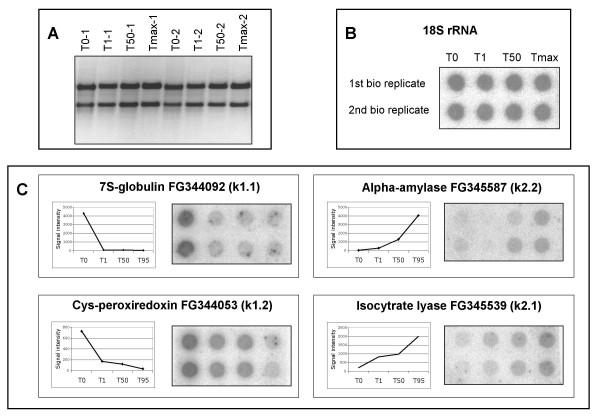
Comparison of results obtained by macroarray and RNA dot-blot analysis. (A) Gel-electrophoresis of RNA samples used for experiments, 1 μg of total RNA is loaded. (B) Control RNA dot-blot: 18S rRNA. (C) Graphical representations of gene expression data obtained by macroarray technique are shown adjacent to the corresponding RNA dot-blots. For (B) and (C): 5 μg of total RNA is loaded on a membrane and hybridized with a 32P-labelled probe.